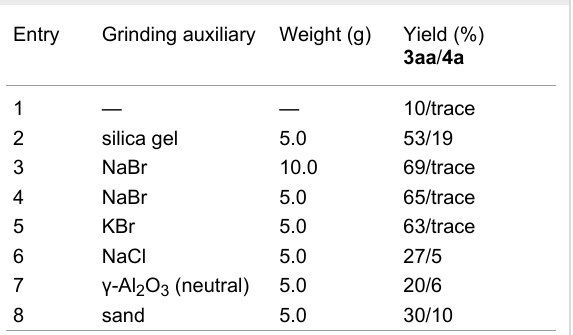
Table 2: Examination of the influence of the grinding auxiliary on the reaction outcome a